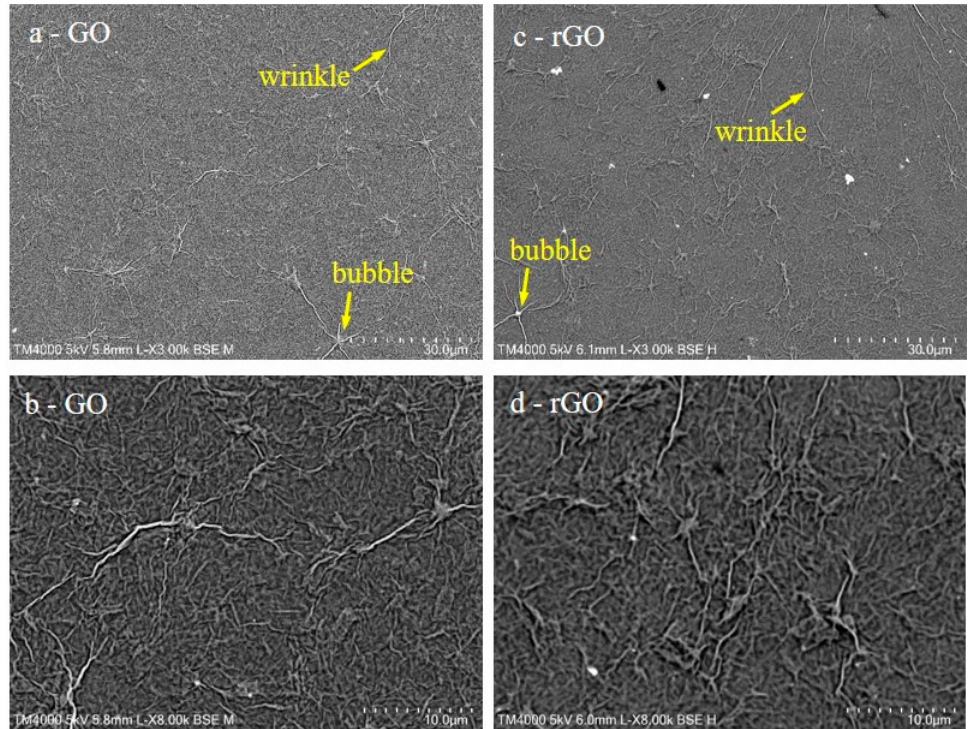
Figure 4. SEM images of GO ( a , b ) and reduced graphene oxide (rGO) ( c,d ) films. SEM images show that GO as well as rGO films completely covered the SiO 2 templates.